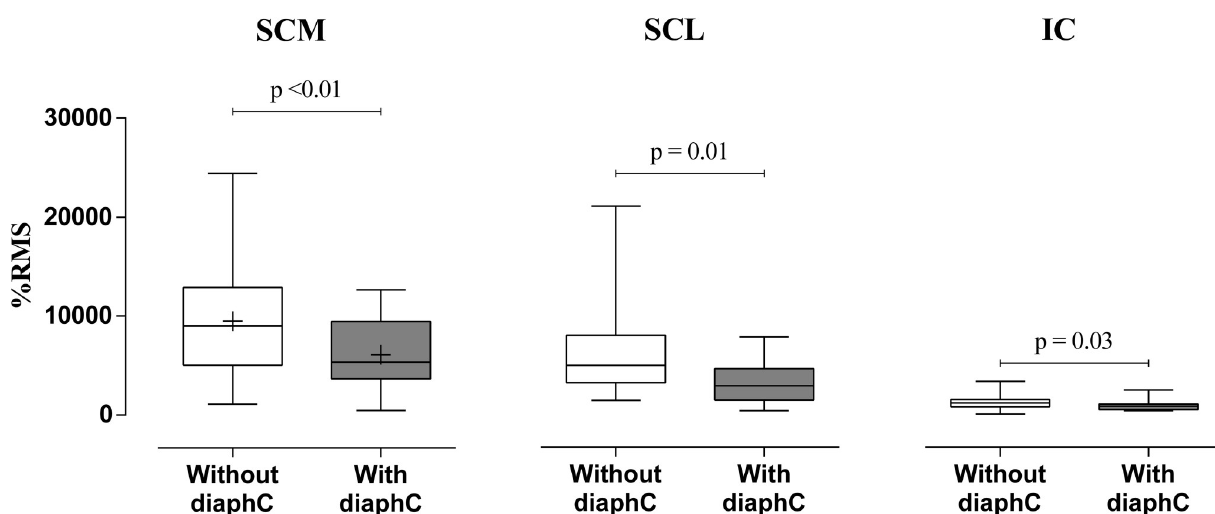
Fig 4. sEMG. Data are shown as median [25–75 th percentile]. Percentage of respiratory muscle activation during the maneuver with and without diaphC. SCM: sternocleidomastoid; SCL: scalene; IC: Intercostal; +, mean for parametric analysis.